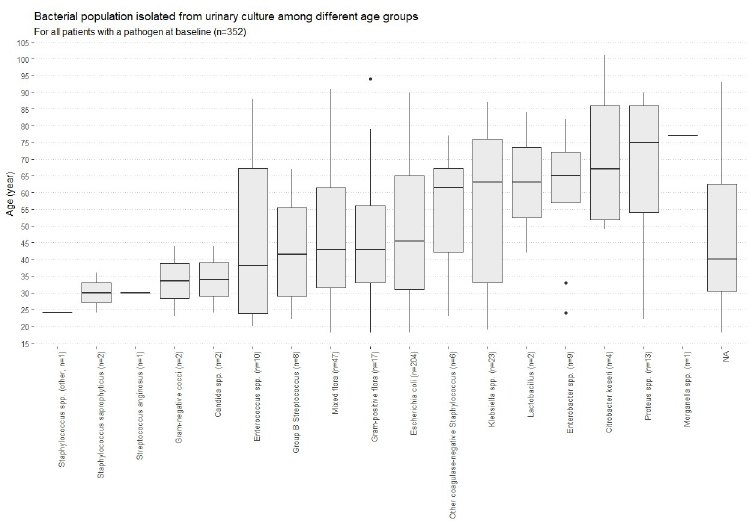
Fig 3. Bacterial population isolated from urinary culture among different age